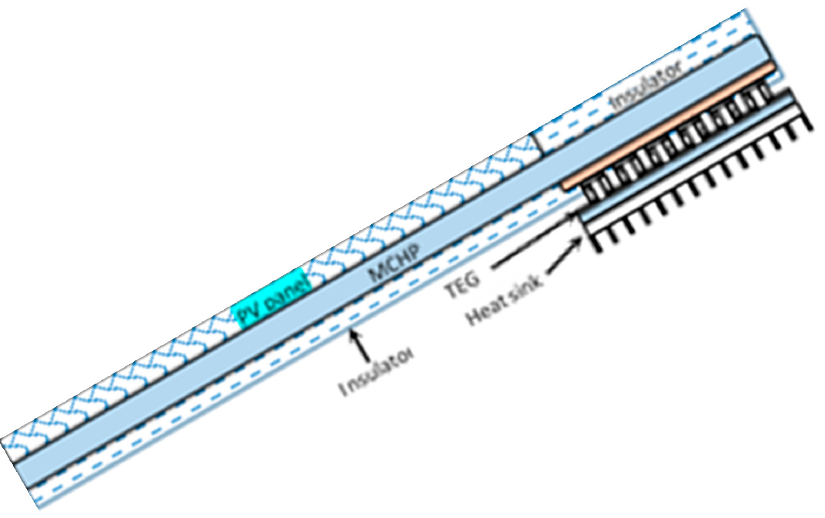
Figure 4. PV-TEG structure with micro-channel heat pipe (MCHP).